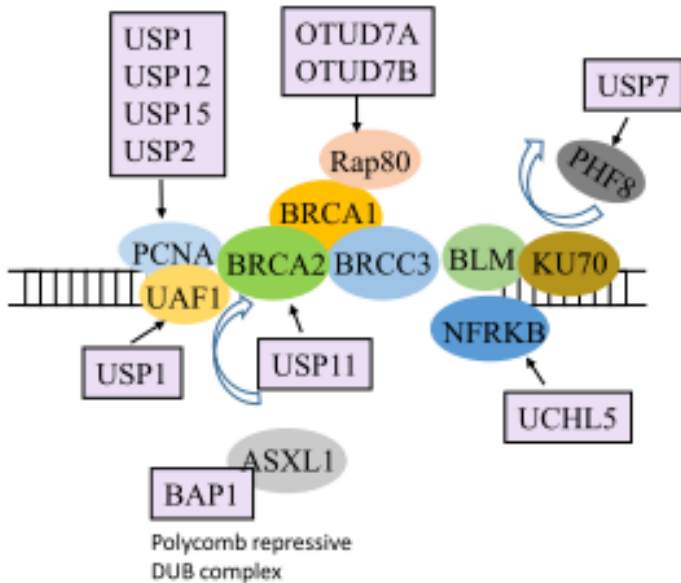
Figure 3. Roles of DUBs in DNA damage response. Various DUBs (light purple) have been shown to interact with molecules (various colors) that play roles in DNA repair and chromosomal stability during DNA damage. Proliferating cell nuclear antigen (PCNA) plays important roles during DNA replication and repair, while BRCA members are the key players in repairing the DNA lesions such as DNA double-strand breaks. In addition, BLM repairs DNA double-strand breaks to maintain genome stability. Detailed information can be found in the main text.